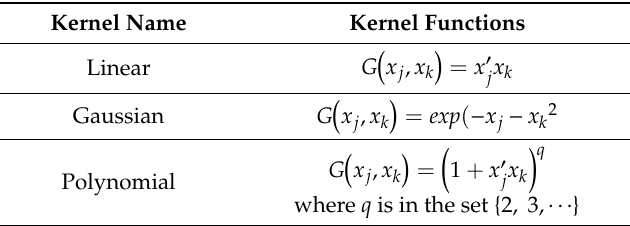
Table 3. Kernel functions for Gaussian process